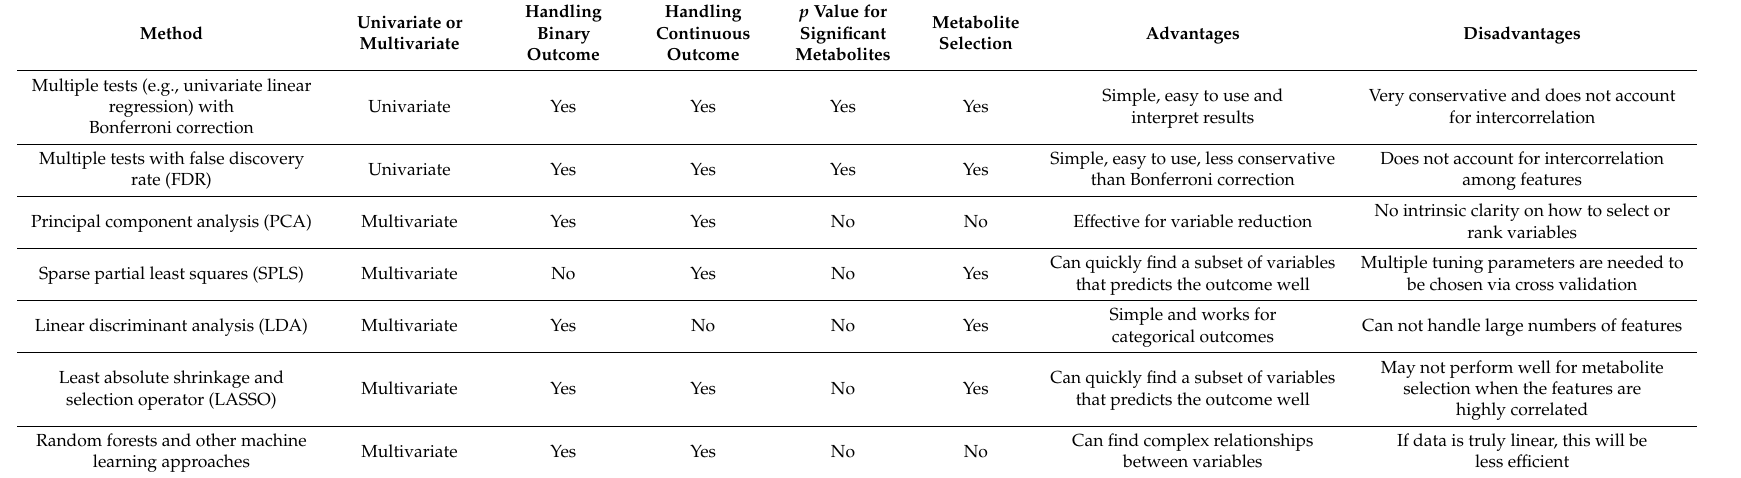
Table 2. Statistical analysis methods for outcomes analyses of human metabolomics